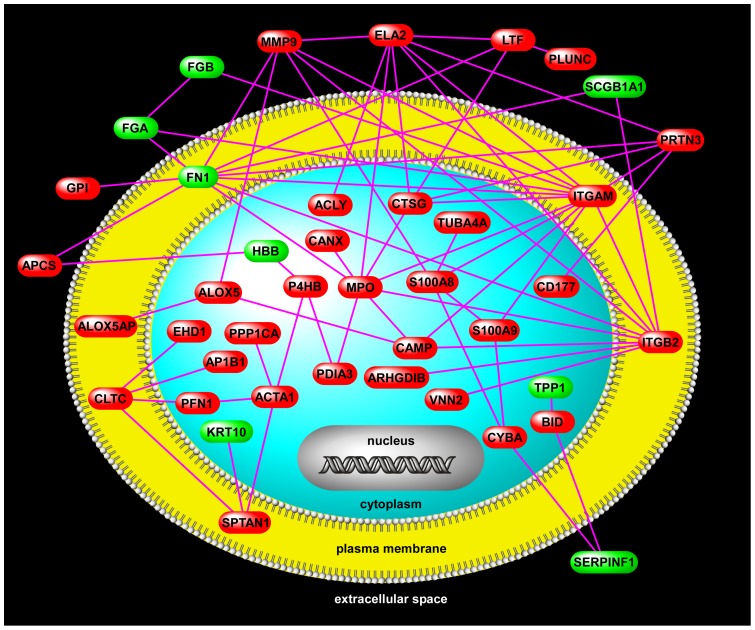
A VAP protein-protein interaction network.The members of this network are comprised of differentially up-regulated (red) and down-regulated (green) proteins in critically ill patients with VAP relative to those without VAP. Connectivity is based on previously published protein interactions. Note the presence of several densely connected hubs (ITGAM, ITGB2, MPO) that may play important roles in the pathogenesis of VAP (see Discussion). Two members of the proposed limited proteomic signature for diagnosis of VAP (S100A8 and LTF) are also network nodes.